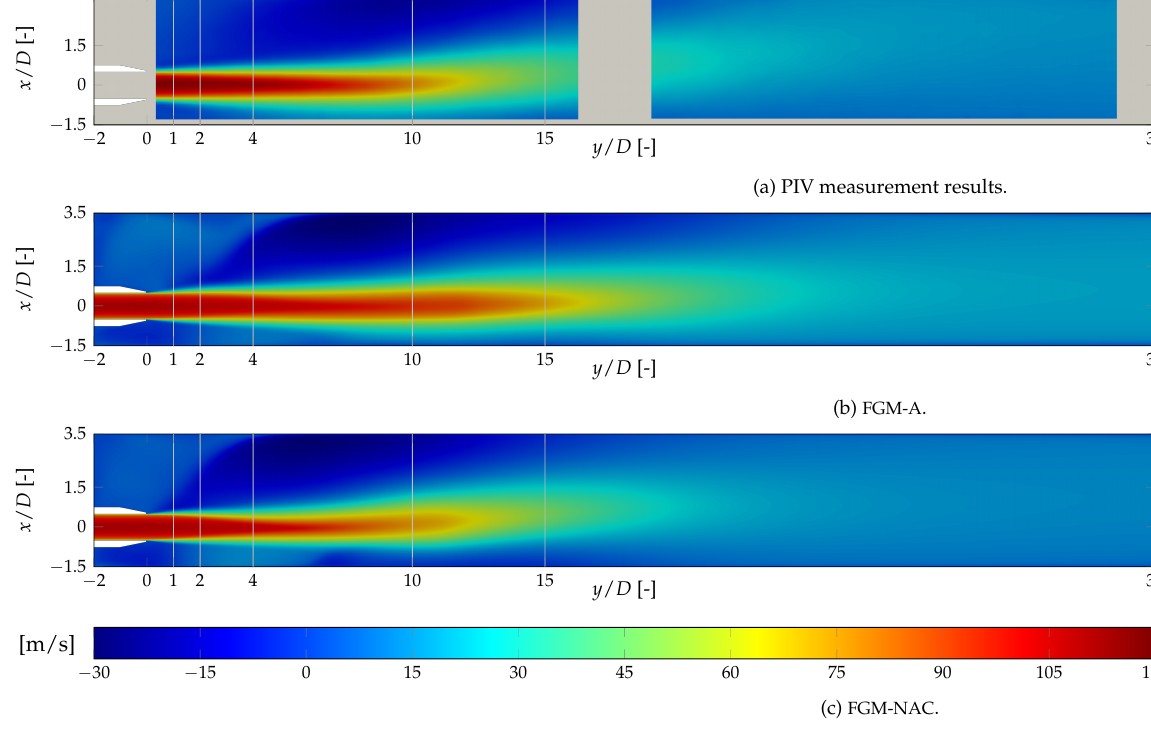
Figure 9. Mean axial velocity.